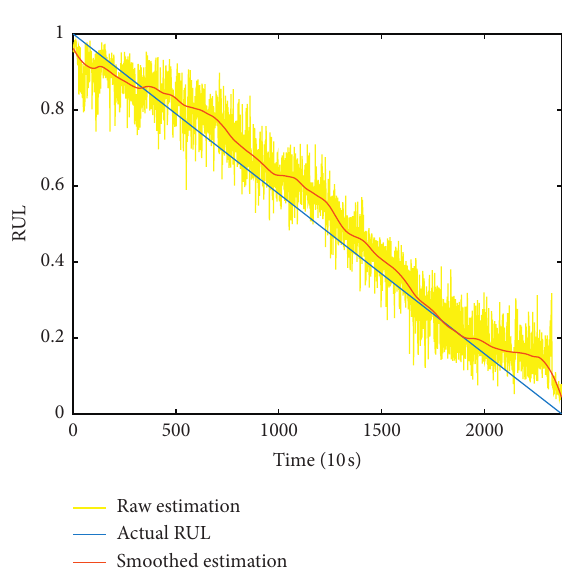
Figure 11: RUL estimation result of bearing 1_3.